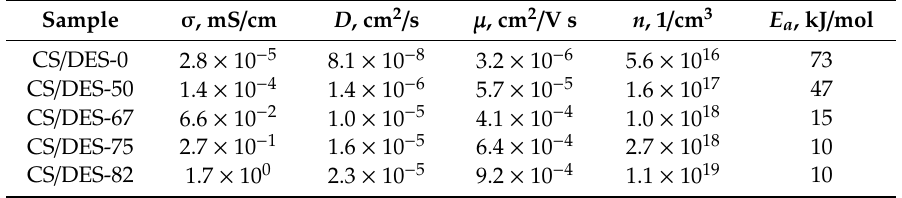
Table 5. The values of room temperature ionic conductivity ( σ ), di ff usion coe ffi cient of ions ( D ), mobility ( µ ) and number density of charge carriers ( n ) and activation energy of ionic conductivity ( E a ) for CS film with LA and films with di ff erent NADES content.